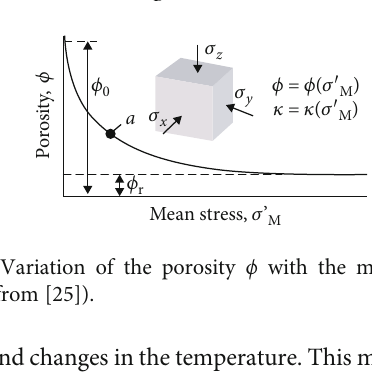
Figure 2: Dimensionless water outlet temperature T